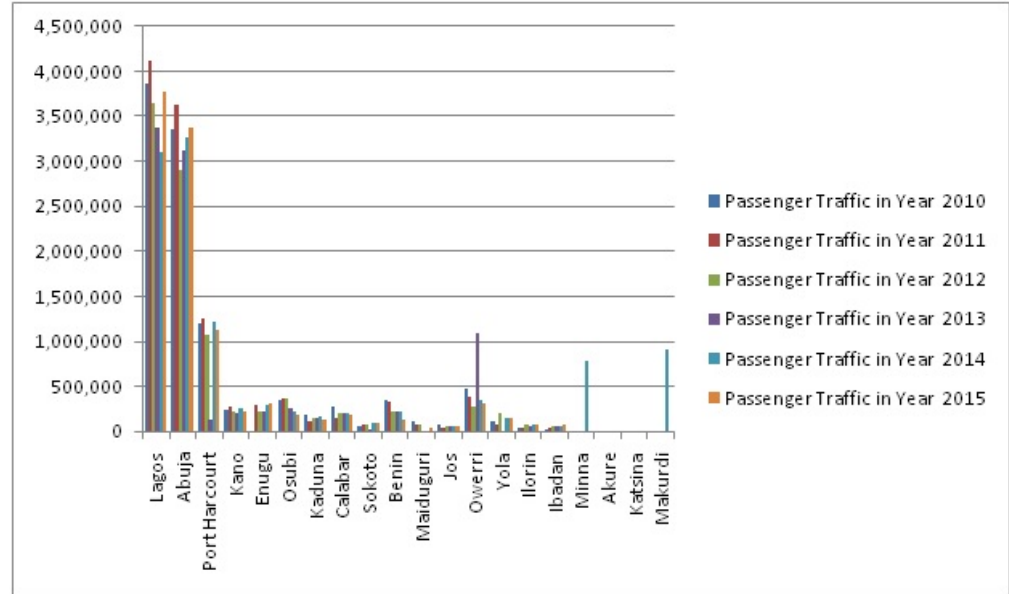
Figure 1. Bar chart domestic air passenger traffic in different airports in Nigeria from year 2010 to 2015.